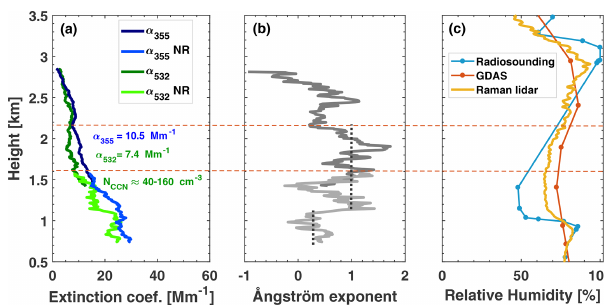
Figure 7. Aerosol observation with the dual-FOV polarization Ra- man lidar on 22 March 2019 during the altocumulus-free period from 07:45–08:45UTC (see Figs. 2 and 4). (a) Particle extinction coefficient at 355 and 532nm (NR indicates the determination from Raman signal profiles measured with the near-range of FOV out tele- scope), (b) Ångström exponent (355–532nm spectral range) com- puted from the extinction profiles in (a), and (c) relative humidity profiles, calculated from the Raman lidar observation of the wa- ter vapor mixing ratio (for the time period from 07:45–08:45UTC, in yellow), by using the respective GDAS temperature profile (not shown), relative humidity taken from the GDAS data set (orange), and as measured with the Punta Arenas radiosonde (blue, launched at 12:00UTC). The mean values of the particle extinction coeffi- cients α 355 at 355nm and α 532 at 532nm for the height range from 1.6–2.15km (driest region, indicated by dashed horizontal lines) are given as numbers in (a) . The layer mean 532nm extinction coef- ficient is used to derive the N CCN range by assuming pure ma- rine conditions (minimum value) and pure urban haze conditions (maximum value) and a supersaturation of 0.2% during droplet nu- cleation events. The dashed vertical lines in (b) indicate different Ångström values for the boundary layer and for the relatively dry part of the free troposphere below the cloud deck.